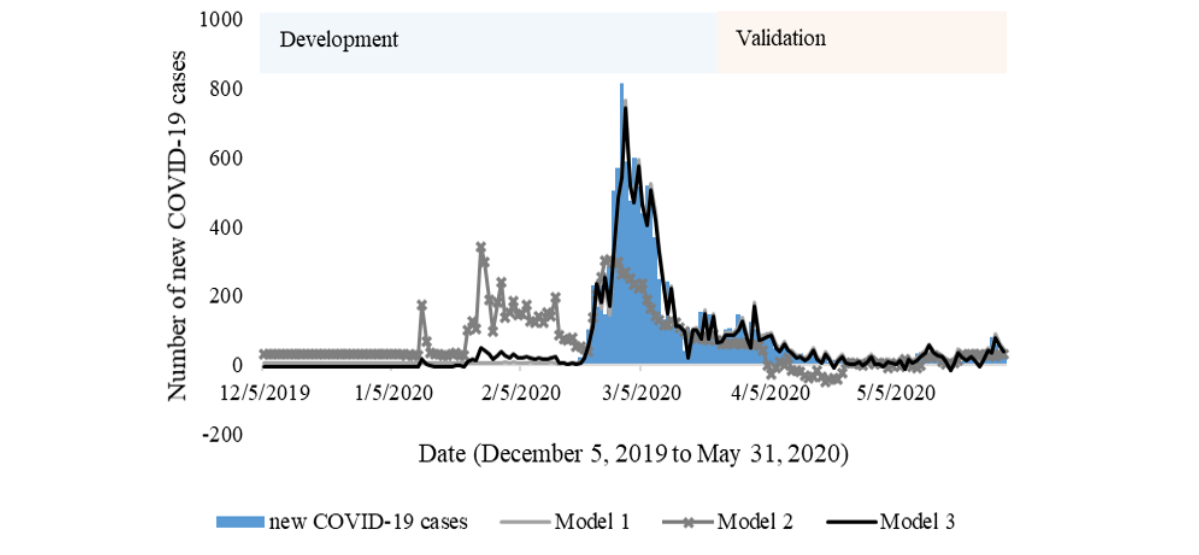
Figure 8. Prediction of new COVID-19 cases in South